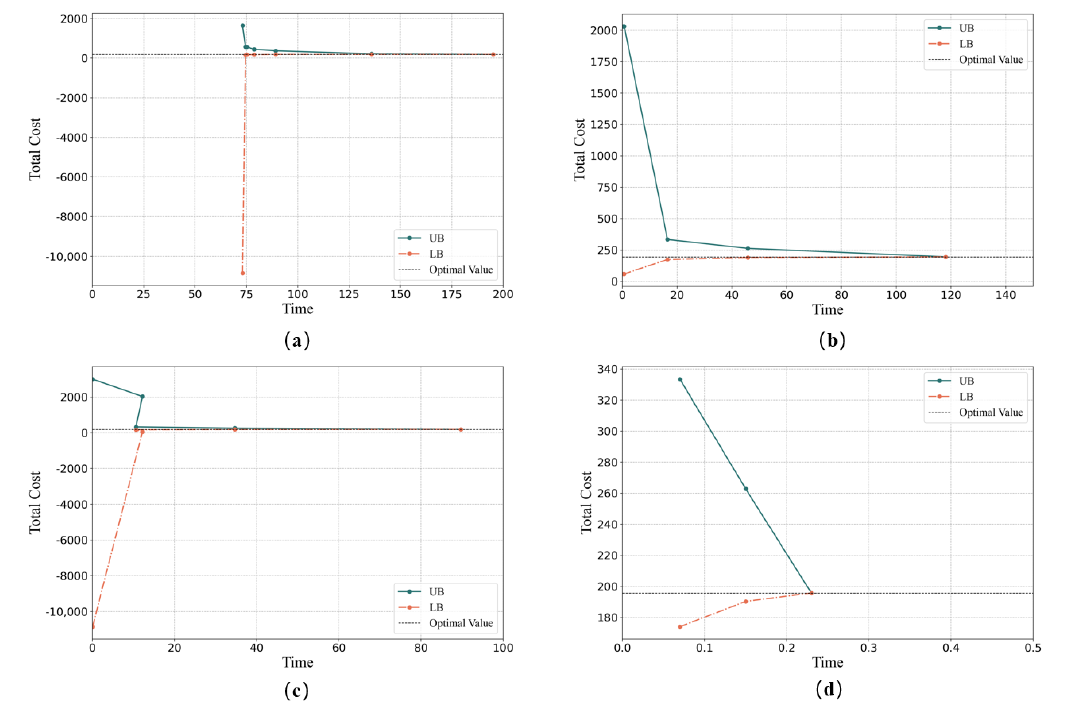
Figure 1. Convergence graphs of different methods: ( a ) Convergence graph of Benders-dual method. ( b ) Convergence graph of C&CG-A method. ( c ) Convergence graph of C&CG-B method. ( d ) Conver- gence graph of improved C&CG-B